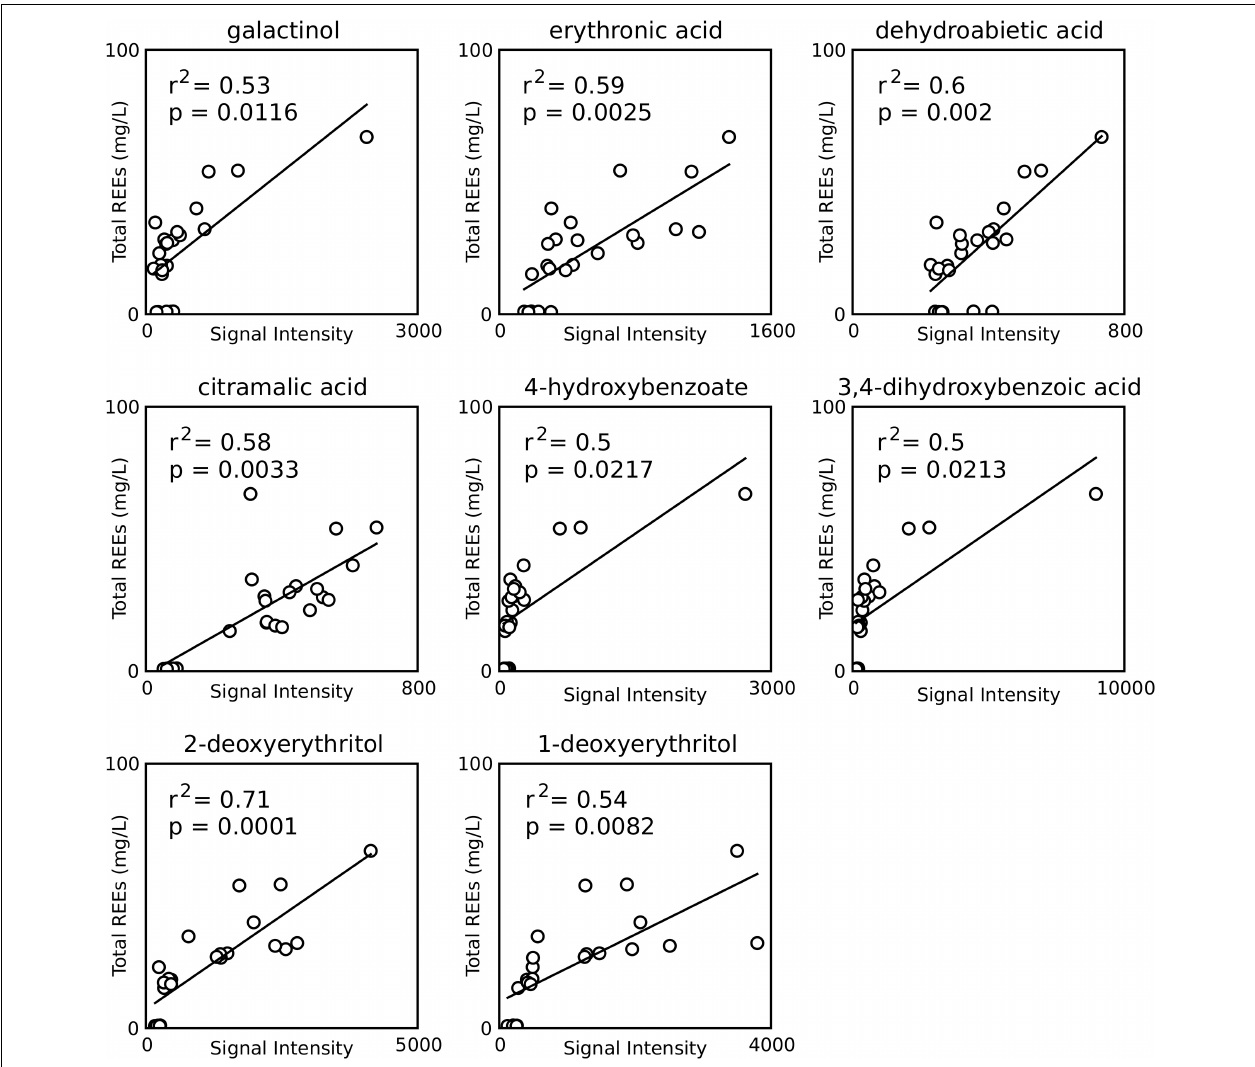
FIGURE 4 | Correlations between metabolite signal intensities and REE concentrations for all samples from the monazite only condition. Only compounds found to have a significant positive correlation and having identification beyond BinBase ID numbers are shown. p -values are Šidák